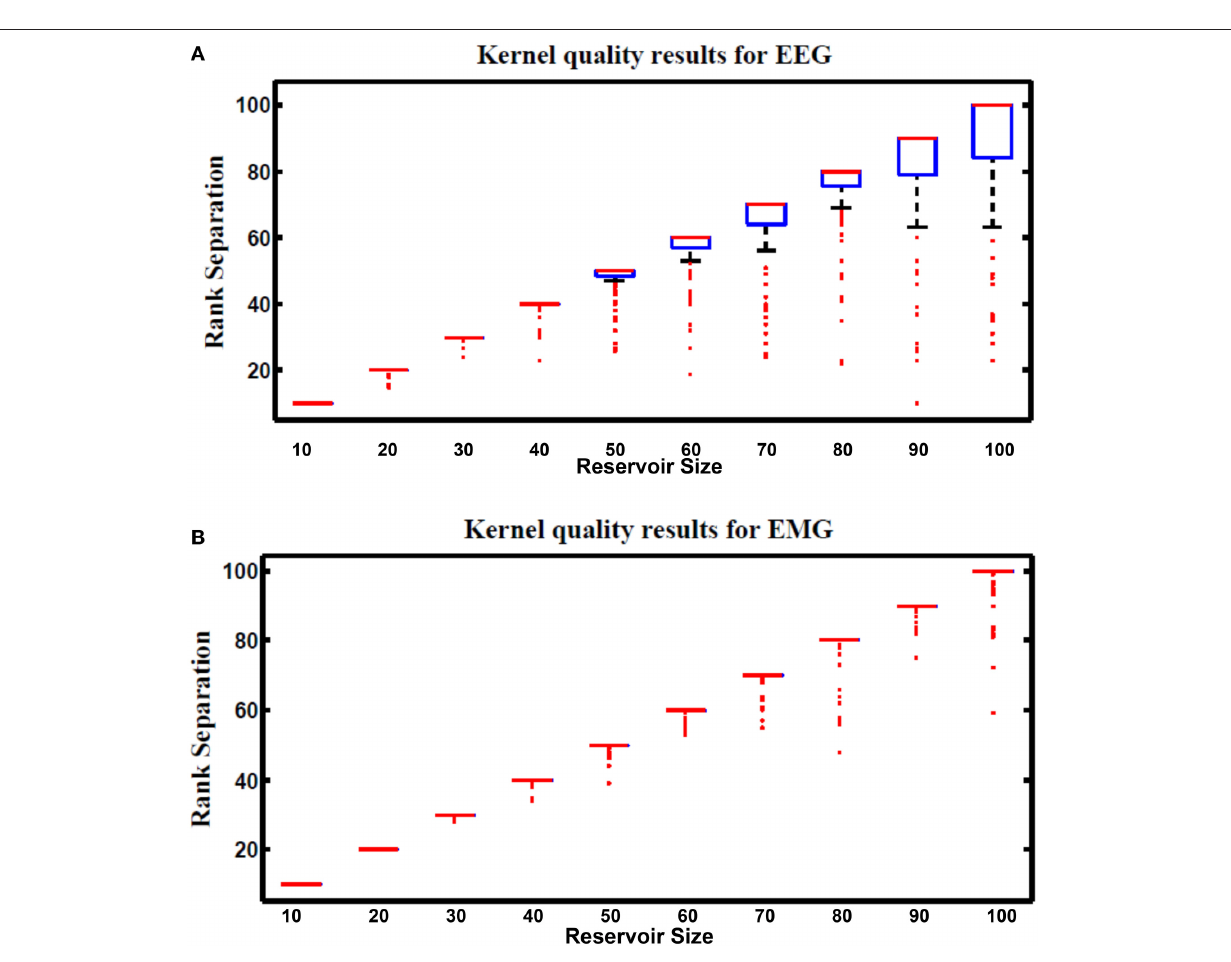
FIGURE 13 | Kernel results vs. different reservoir sizes for hybrid topology reservoir testing (A) EEG and (B) EMG signals. The boxes represent the 25th and 75th percentiles of the measurements. The whiskers represents values out of this 25–75th percentiles. Since the percentiles range is centered in (B) , the sizes of the boxes in (B) are very small (just a line that represent the mean of the